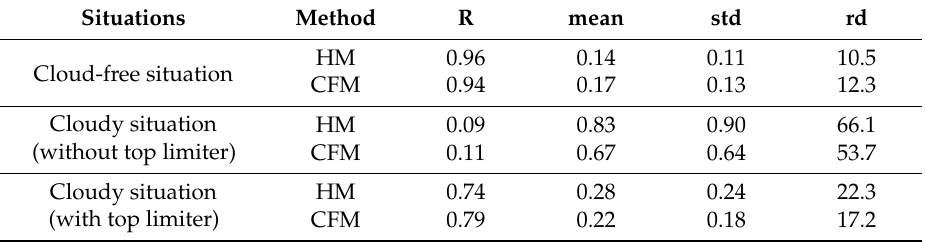
Figure 8. Similar to Figure 7, but in cloudy situations. The blue open dots represent the comparison results of ABLH determined by theta gradient (vertical coordinate) and determined by HM ( a ) or CFM ( b ) (horizon coordinate) without height limitation, the red stars indicate the comparison results after the top limiter is given for HM and CFM. R represents the correlation coefficients, blue represents no top limiter, and red represents with the top limiter. Table 1. Correlation coefficients (R), absolute height differences (mean and standard deviation (std) in km) between ABLH determined by theta gradient and by the Haar wavelet covariance transform method (HM) or curve fitting method (CFM) in different situations, as well as mean value of relative absolute differences relative to theta-gradient-determined ABLH (rd, in 100%).